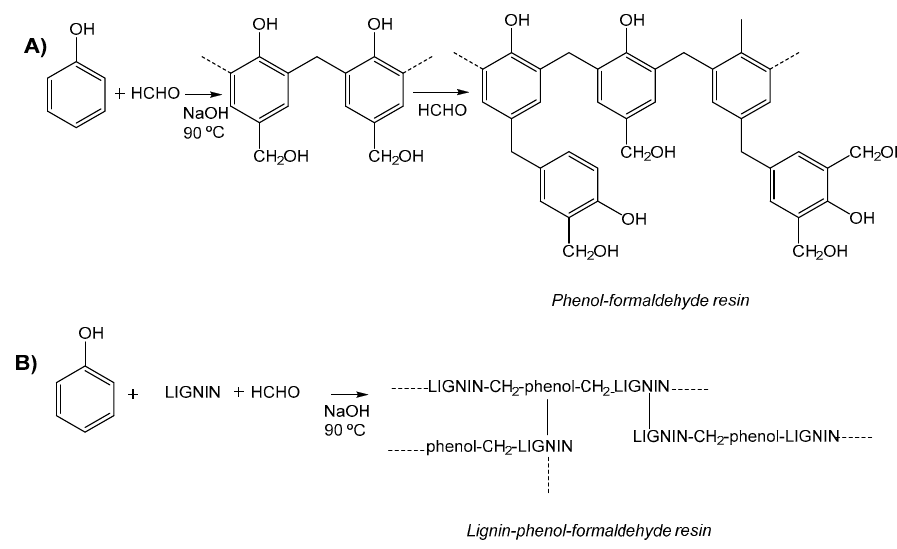
Figure 4. ( A ) Schematic representation of the synthesis of general phenol-formaldehyde resins. ( B ) Schematic representation of the synthesis of lignin-phenol-formaldehyde resins.